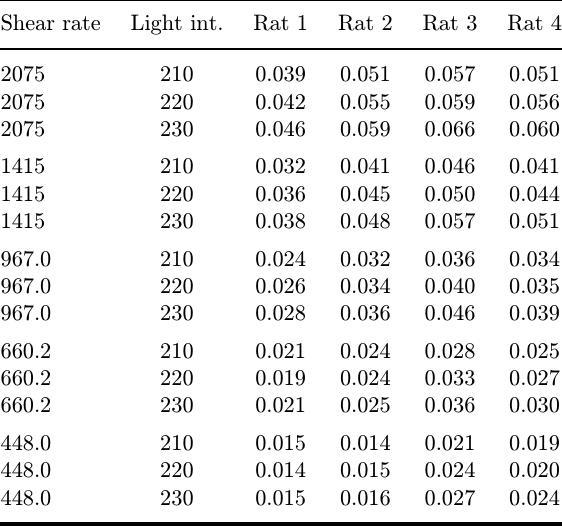
Table 1. Normalized light intensity at the isointensity lines of the di®raction patterns. The table shows the number f 0 determined by the formula (3). The data are given for the blood samples taken from four rats, for dif- ferent shear rates, and at di®erent levels of light intensity (210, 220 and 230 in units of Fig. 6). Shear rate Light int.